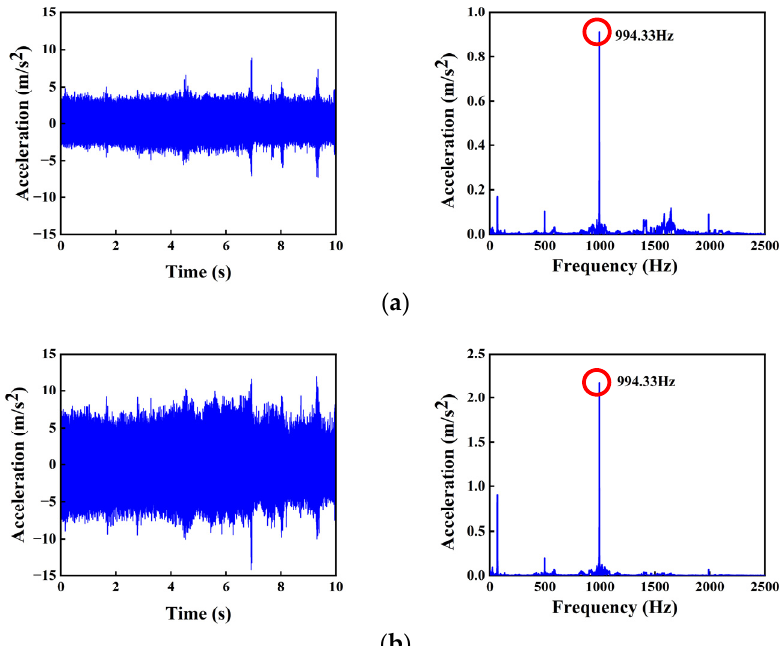
Figure 7. Time domain and frequency domain of vibration acceleration at 40 km/h maglev train speed: ( a ) lateral and ( b ) vertical.